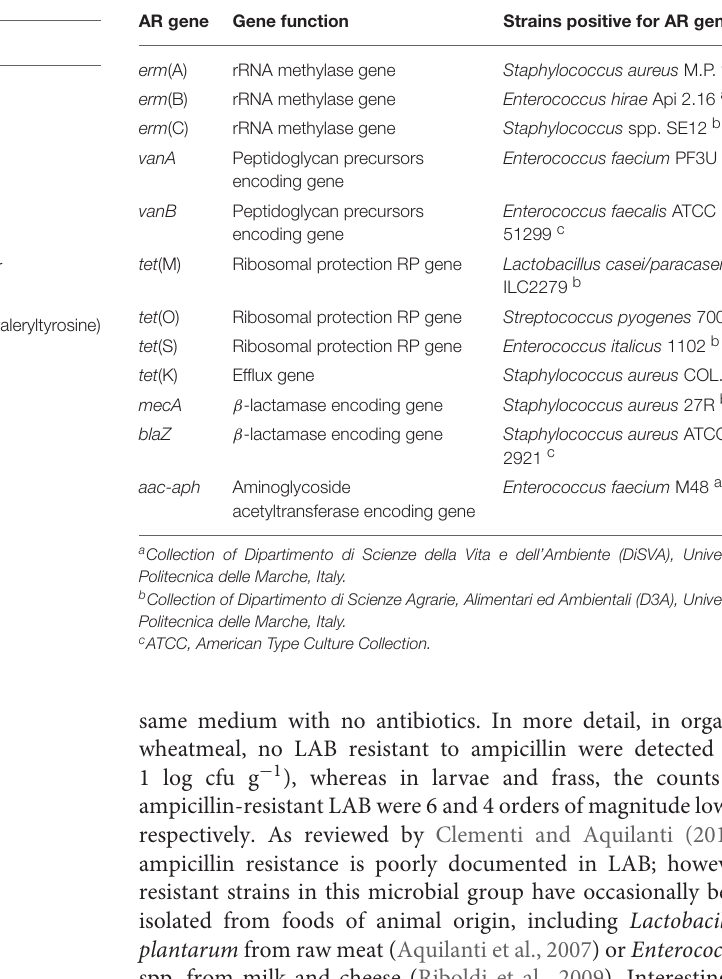
TABLE 3 | Bacterial reference strains used in this